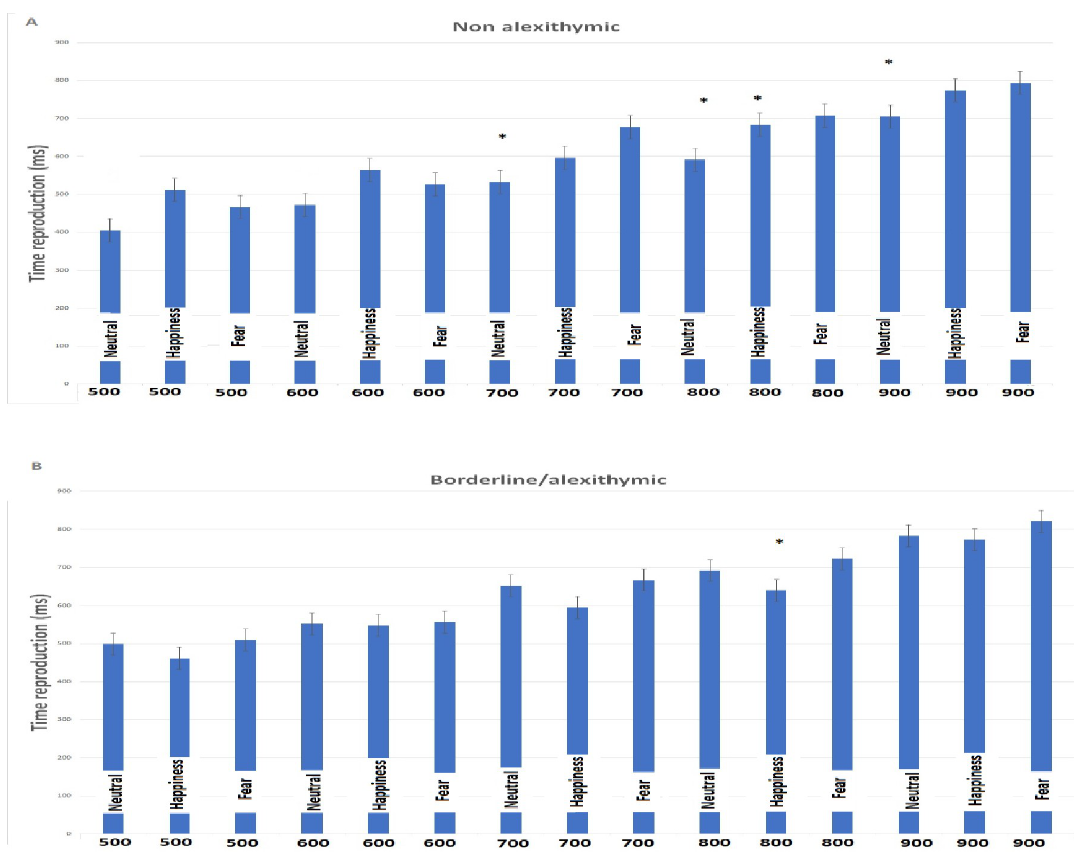
Fig 2. The figure provides time reproduction means for each facial expression and the respective temporal interval. � Indicates significant difference for one sample t-test for single means. Vertical bars denote ± standard error of